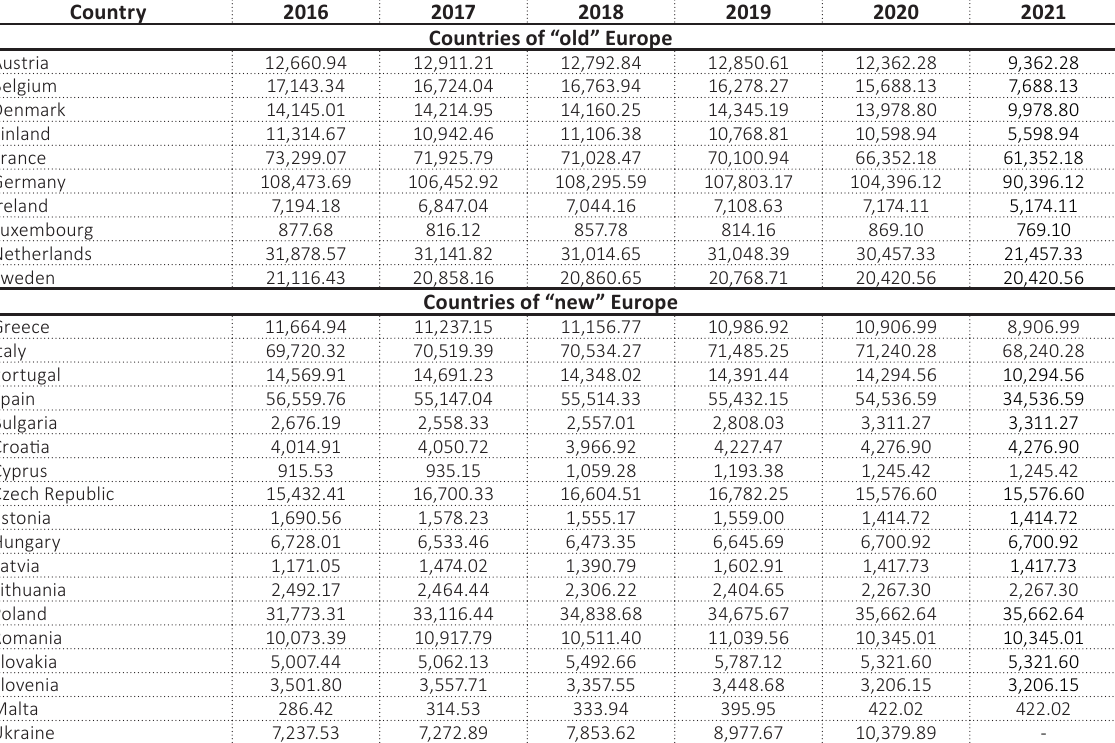
Table D1. Articles in scientific and technical journals, pieces (Х4)